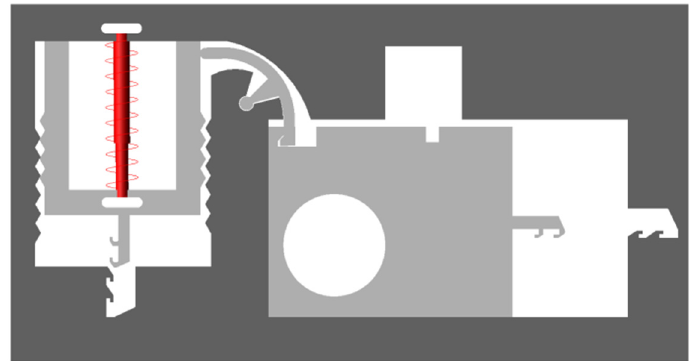
Figure 10. Simulation model of the arming device.